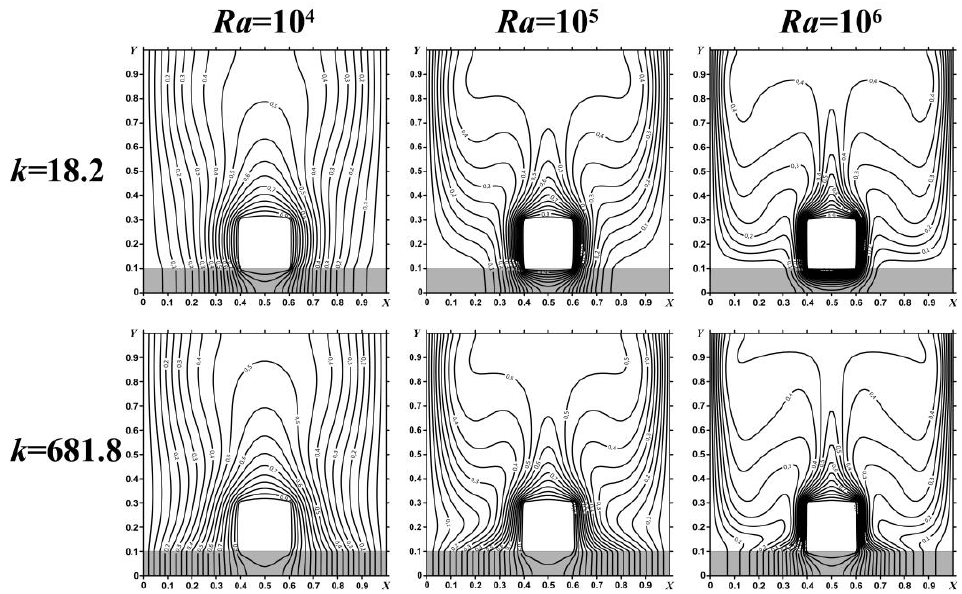
Figure 6. Isotherms for a square heater for different Ra and k .